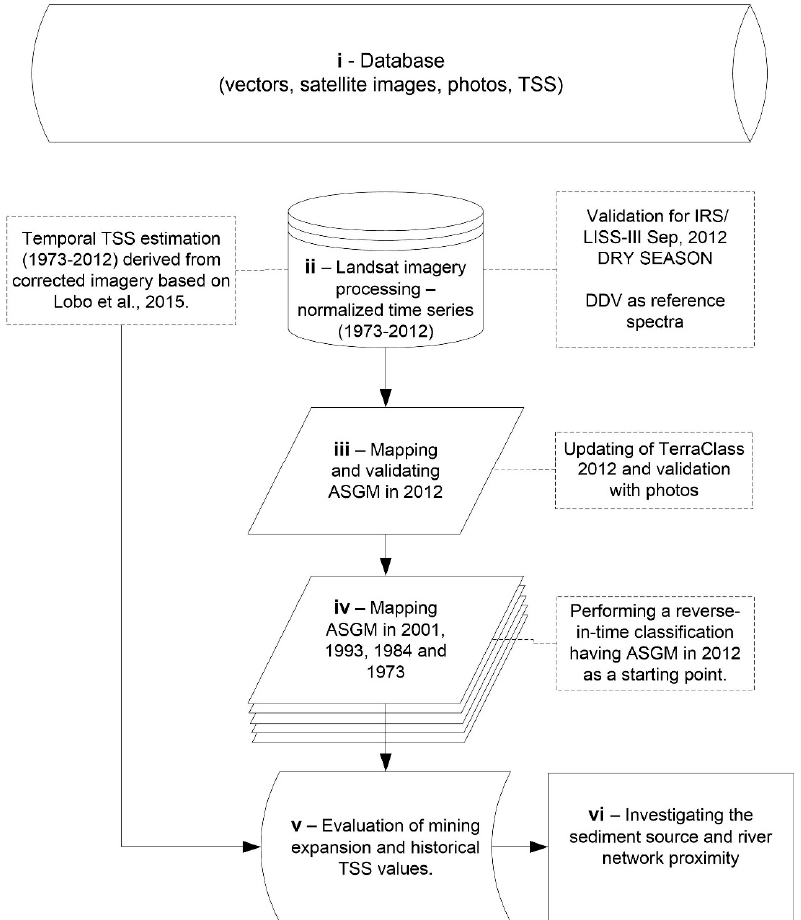
Figure 2. Flowchart of the methodology applied in this paper. ( i ) Database including satellite images, auxiliary vectors, photos and TSS from [12]; ( ii ) Landsat image processing to create a normalized time series from 1973 to 2012 from land use and water siltation extraction; ( iii ) Map ASGM in 2012 and validated with photos; ( iv ) Conducted a reverse in time classification of ASGM in 2001, 1993, 1984 and 1973; ( v ) Combined temporal analysis between TSS and ASGM expansion; ( vi ) Investigation of the sediment source resulted of ASGM